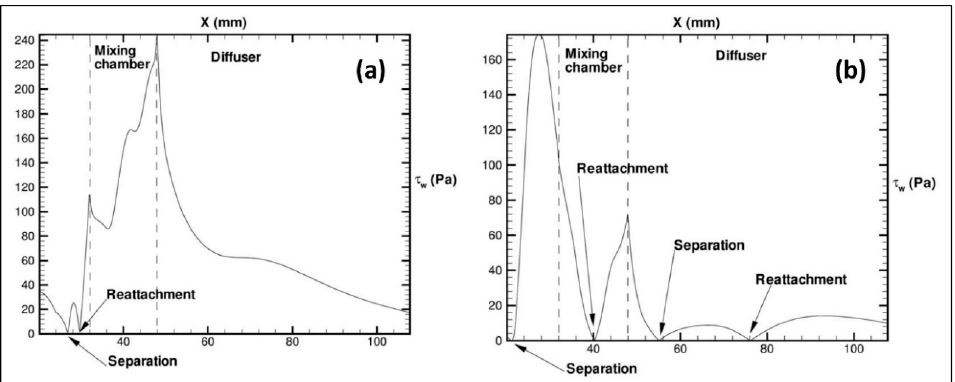
Figure 23. Typical structure of flow separation and reattachments inside ejector, wall shear stress along the ejector with: ( a ) k- ε model; ( b ) k- ω model [218]. Hemidi et al. [242] use of Standard k- ε and k- ω SST models with air indicated that Standard k- ε model predicted both on-design and off-design experiments for entrainment and compression with less than 10% discrepancy.